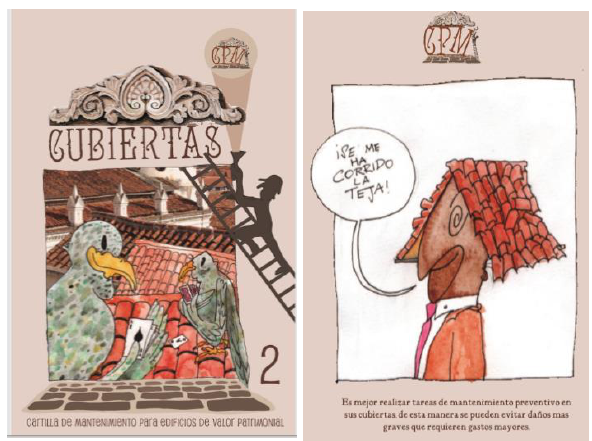
Figure 6. Maintenance chart Nº2.